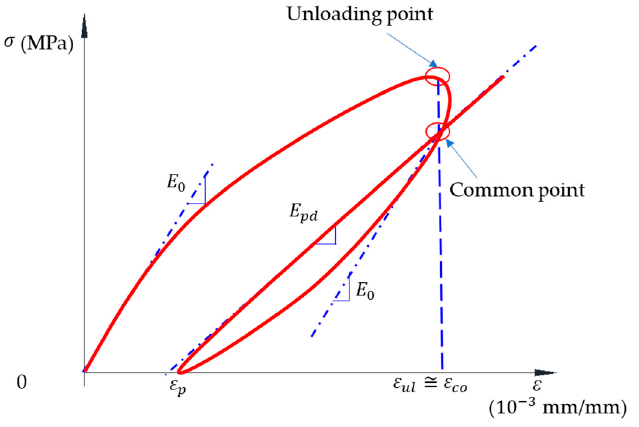
Figure 13. Definition of parameters in the axial stress–strain relation of the cyclic test.